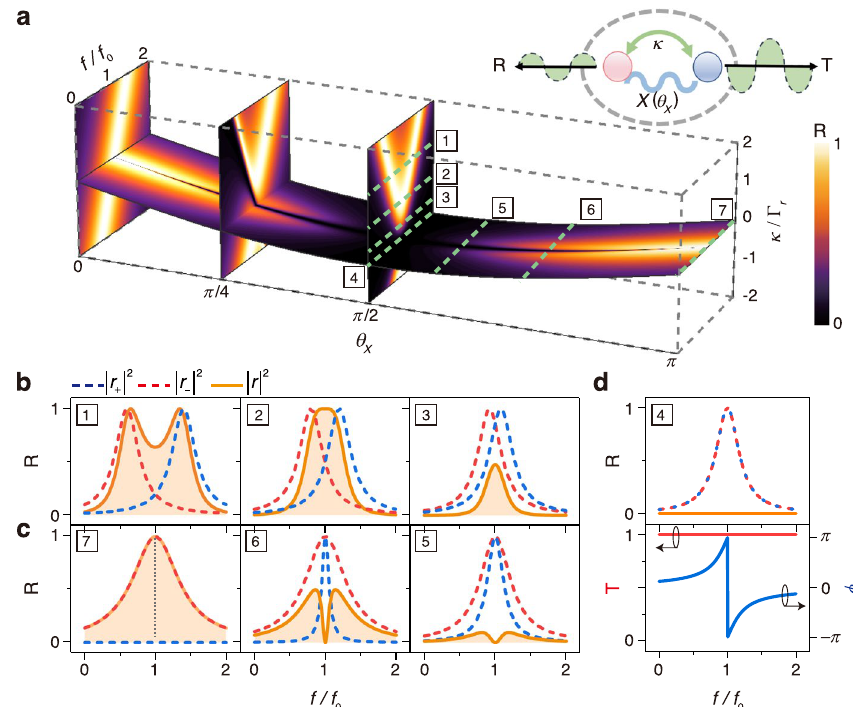
Im( X ) 0 satisfied − = 1, = π /2, 3 π /5, 3 π /4, =